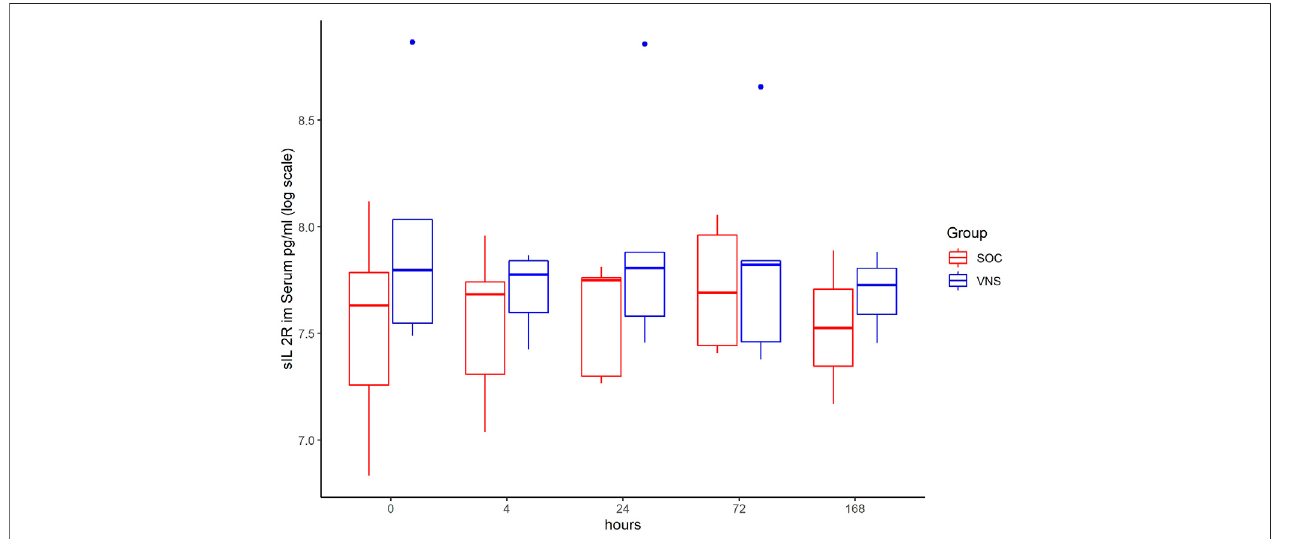
FIGURE3| MediansIL-2RlevelwithInterquartileRangeofpatientsreceivingauricularVagusStimulation(VNS=blue)andpatientsonlyreceivingStandardofCare (SOC = red) after 0, 4, 24, 72, and 168 h of study inclusion.